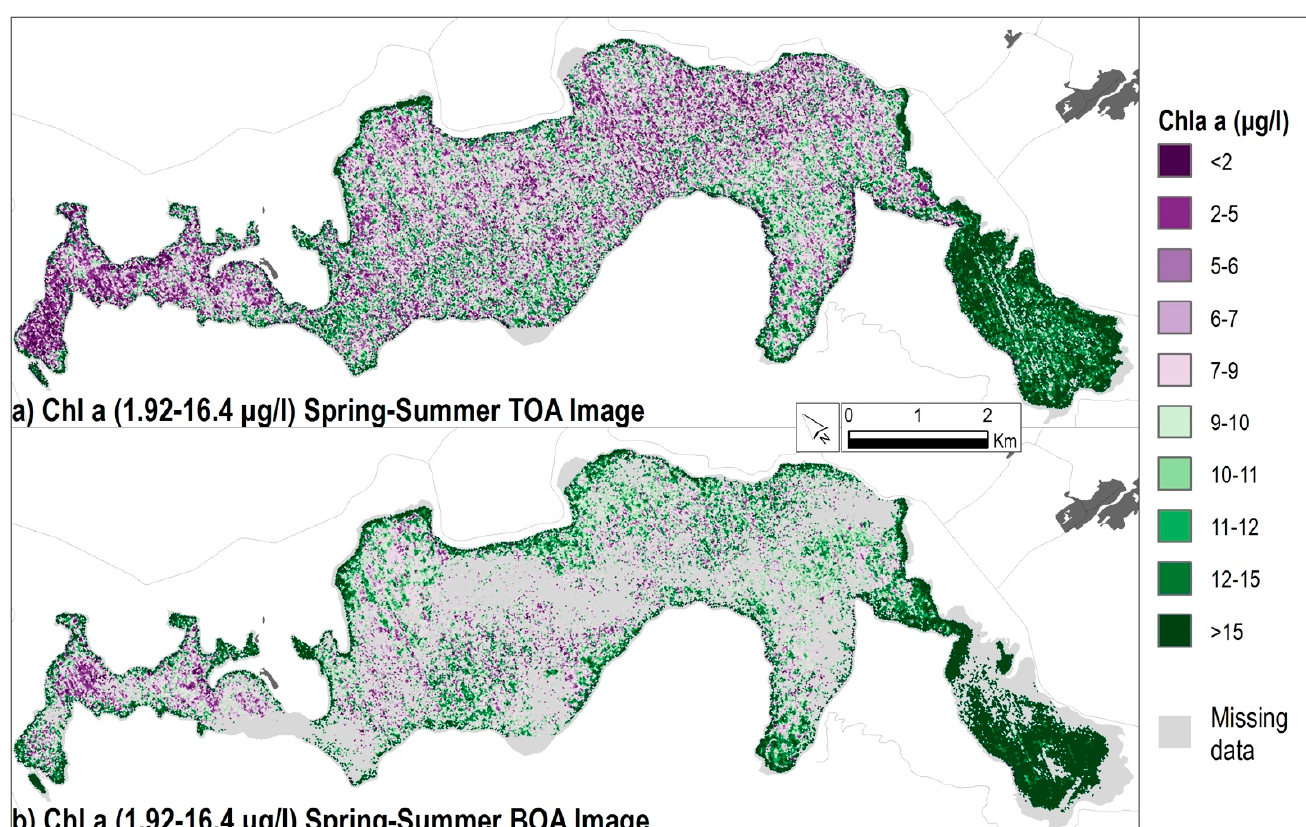
Figure 8. Chl-a concentration maps based on MLR for the spring-summer period, with maximum concentrations, included: ( a ) made with TOA data (L1C) and ( b ) made with BOA data (L2A).